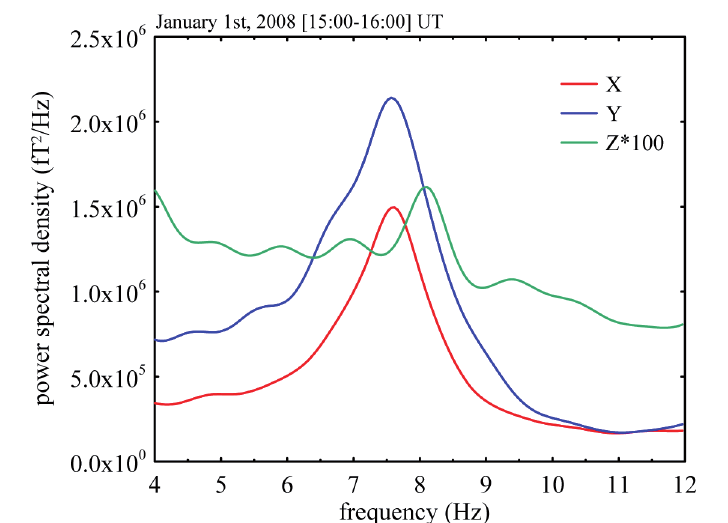
Fig. 8. An example of the SR fundamental mode. Note that the peak frequency f x = 7.6Hz is equal to f y , where- as f z = 8.2Hz. For clarity the values of the Z component are multiplied by